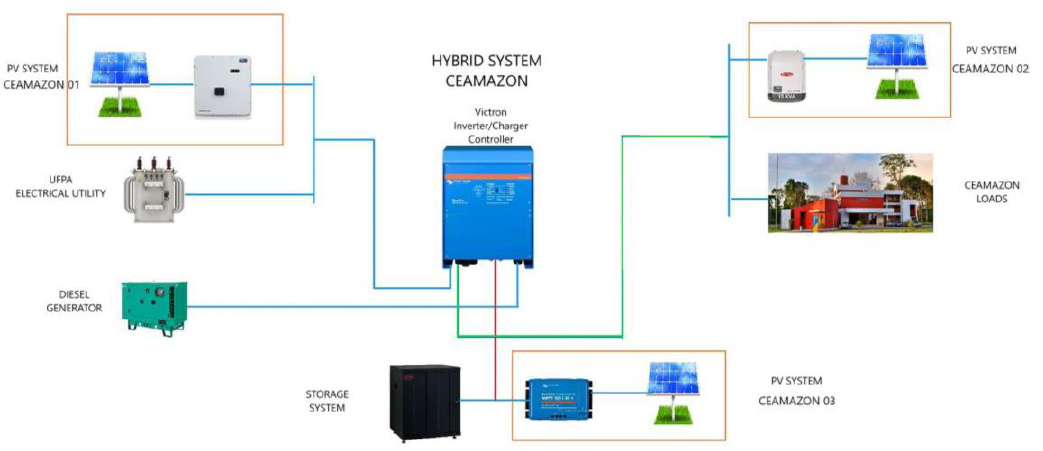
Figure 4. Hybrid system components at CEAMAZON.